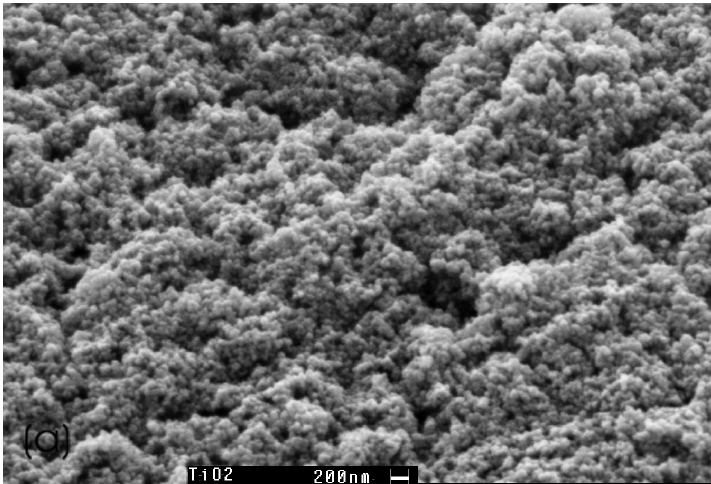
Figure 4. Degradation of Benzene, Toluene and Xylene in contaminated air with TiO